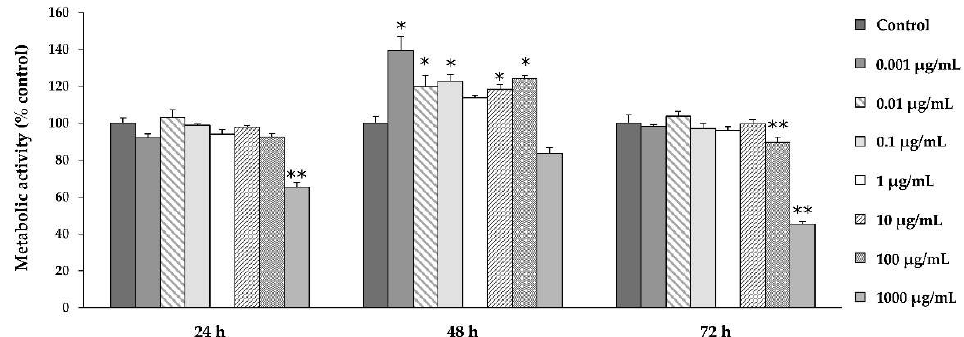
Figure 1. The effect of glucanoligosaccharide ( Ps -GOS) on osteoblastic cell proliferation. MC3E3-E1 cells were treated with the indicated concentrations of Ps -GOS for 24, 48, and 72 h. Cell proliferation was measured by MTT assay. The result shows percentage of metabolically active cells relative to untreated cells (control = 100% viability). Each point of data represents the means of four replicate samples ± SEM. * = p < 0.05, ** = p < 0.01 when compared to the control.